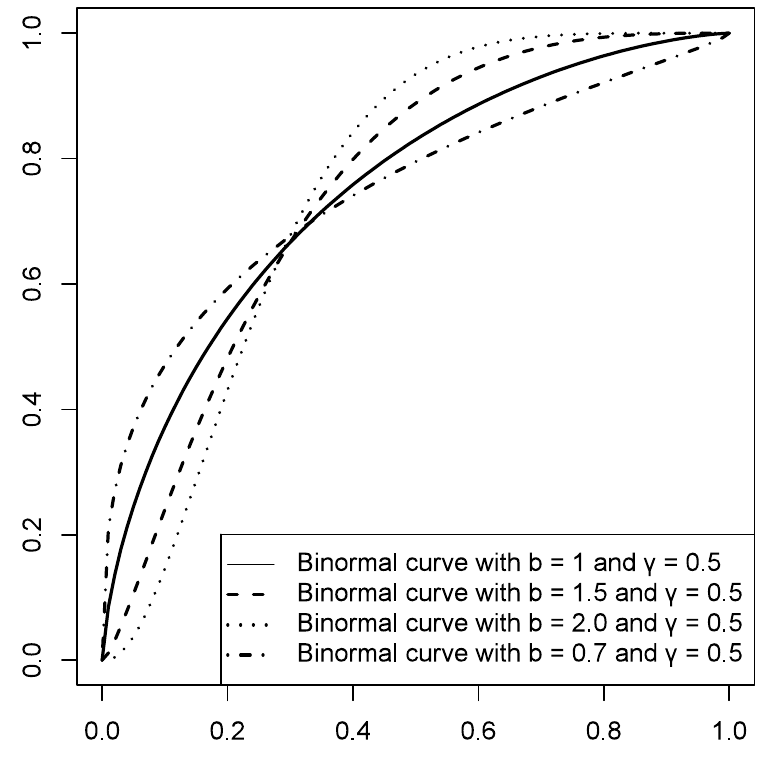
Figure 2. Binormal curves.